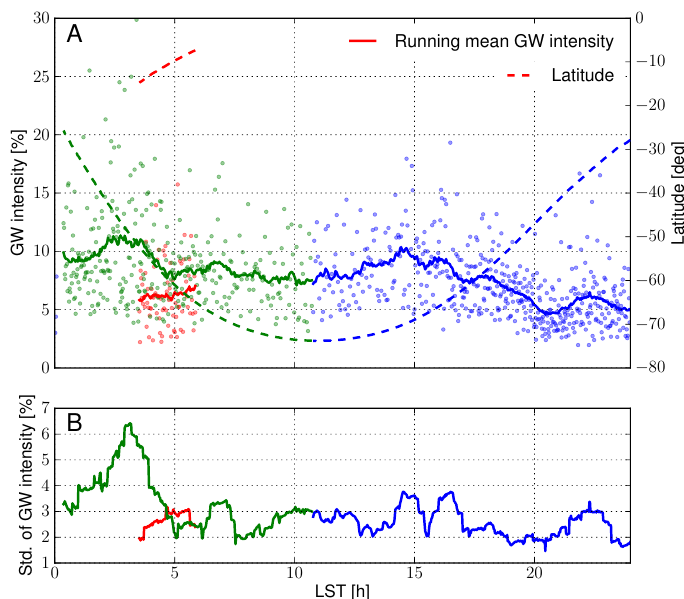
Figure 7. ( A ) Gravity wave intensity as a function of local solar time (LST). The running mean (solid line) has been calculated by averaging over passes with pericenters within the around the given LST. A maximum of 40 passes closest in time has been considered. The dashed line marks the pericenter latitudes. ( B ) RMS deviations with respect to the running mean.